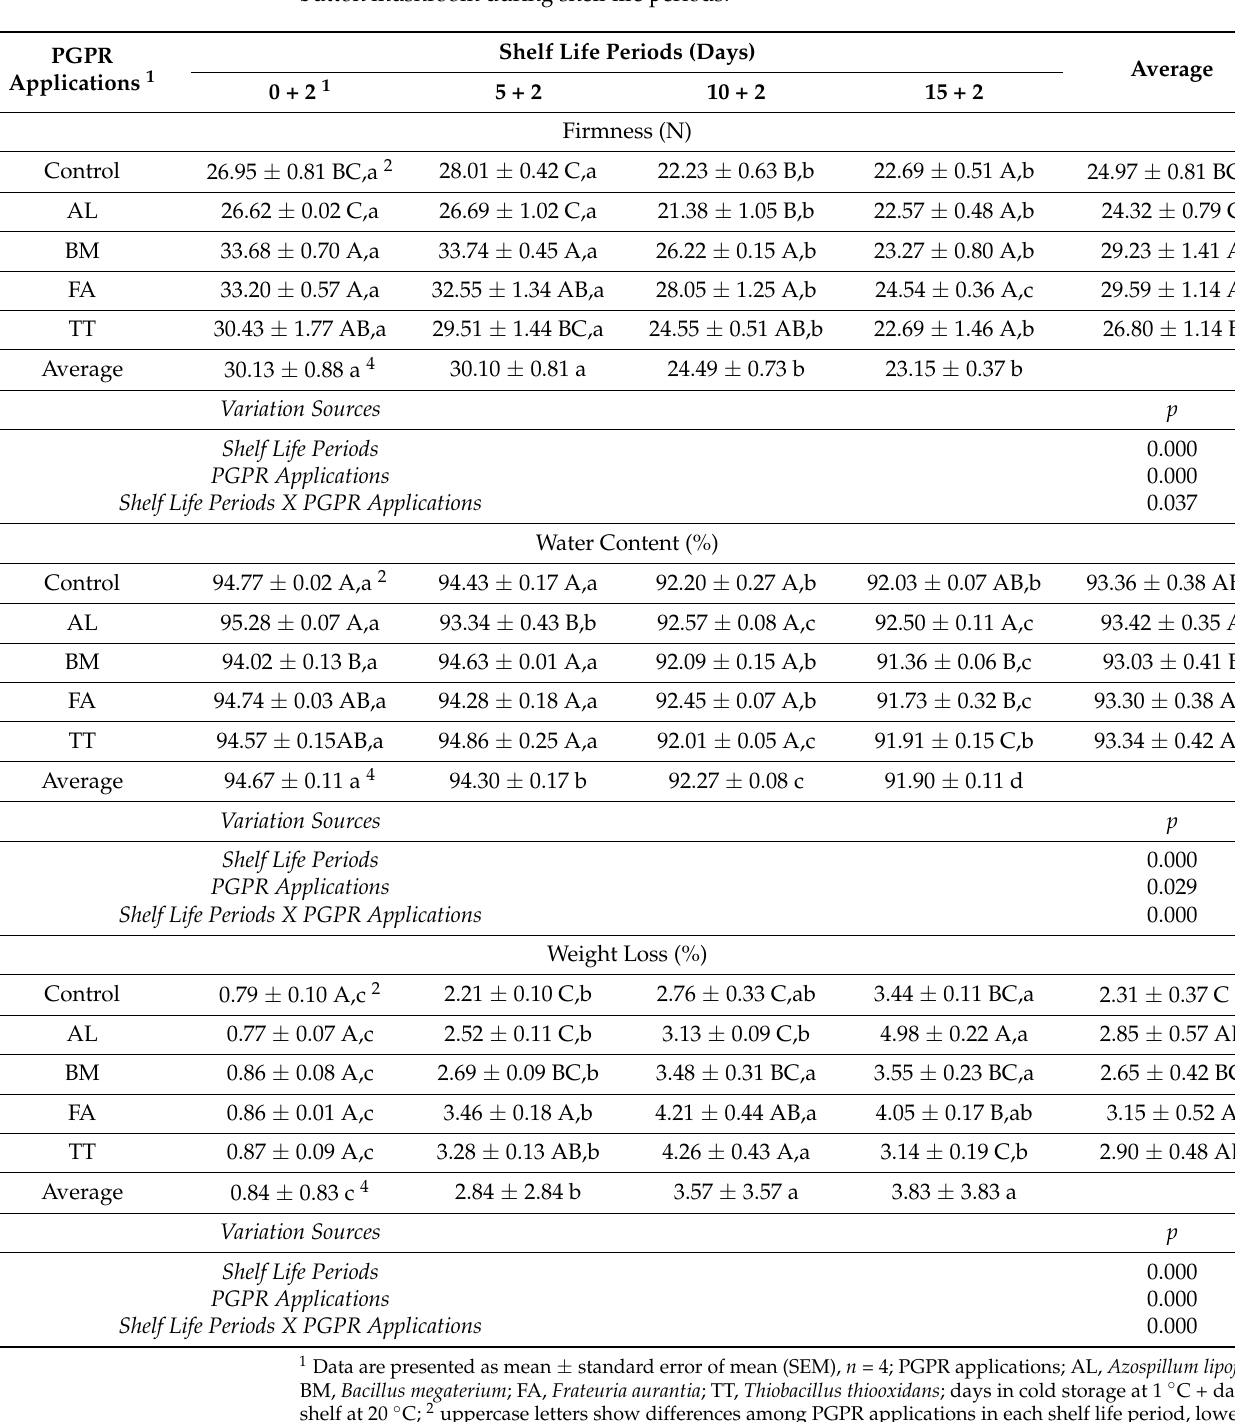
Table 4. The effect of different PGPR applications on firmness, water content and weight loss in white button mushroom during shelf life